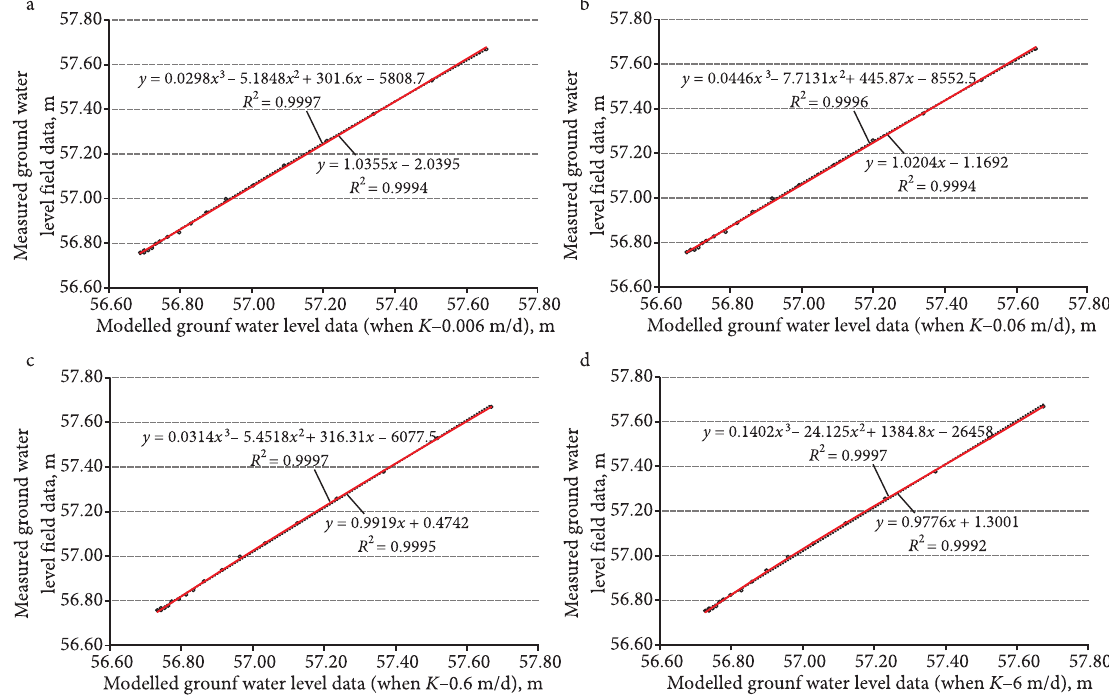
Fig. 6. Impact of the modelled cross drains on the water table depression in the area drained when the space between trenches is 30